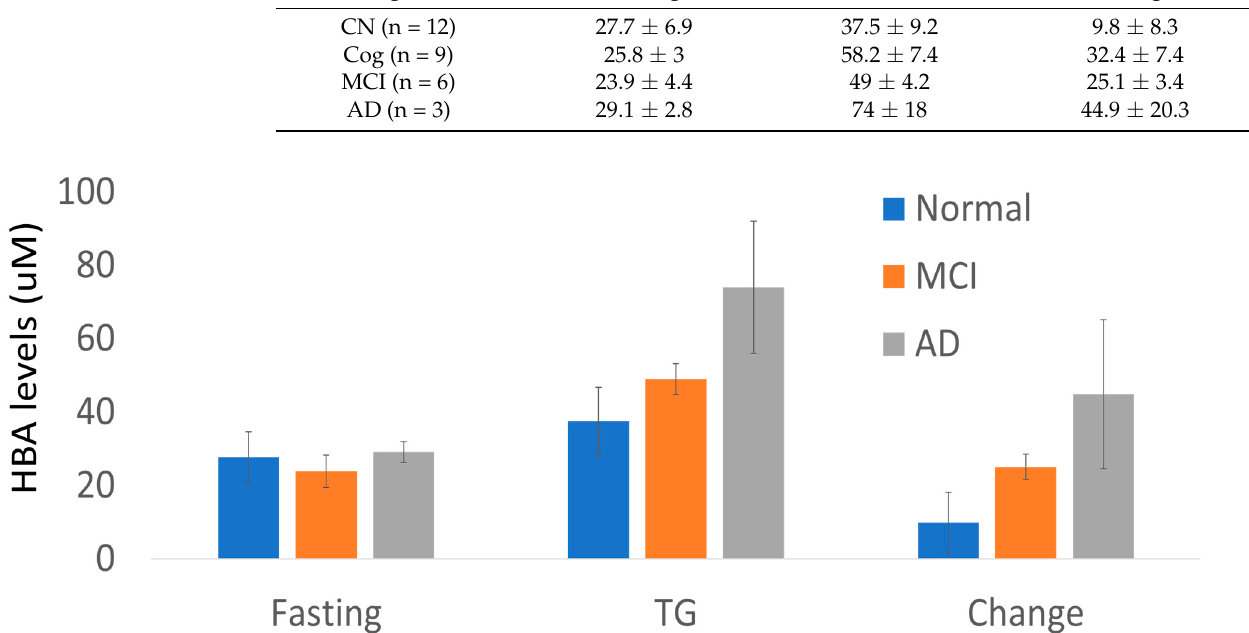
Figure 3. Quantitative HBA levels (uM) by cognitive diagnosis (adjusted for age) given are mean +/ − standard error.